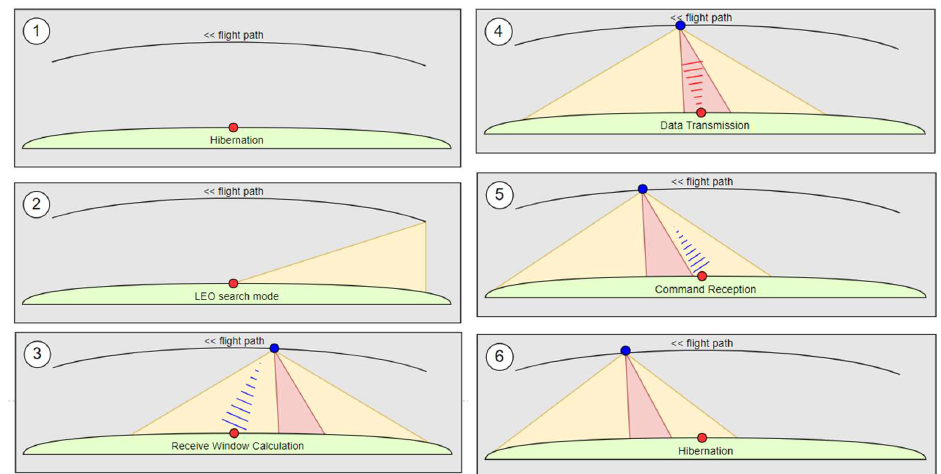
Figure 2. Tag wake-up procedure during ISS overflight: hibernation phase (1), satellite search phase (2), downlink beacon reception (3), uplink window (4), downlink tag command reception (5), orbit propagation for next overflight and go back to hibernation (6).